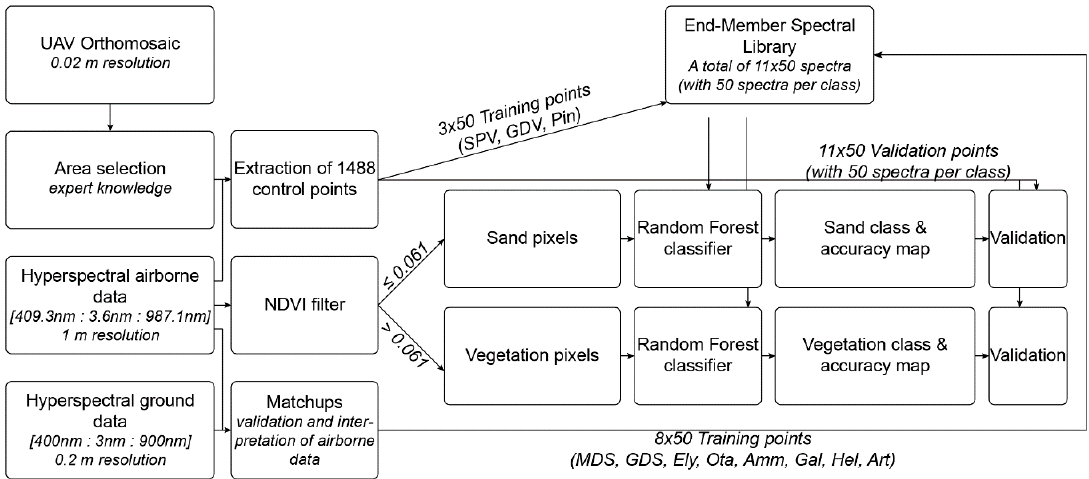
Figure 4. Flow chart depicting the di ff erent steps employed in the airborne VNIR image classification.